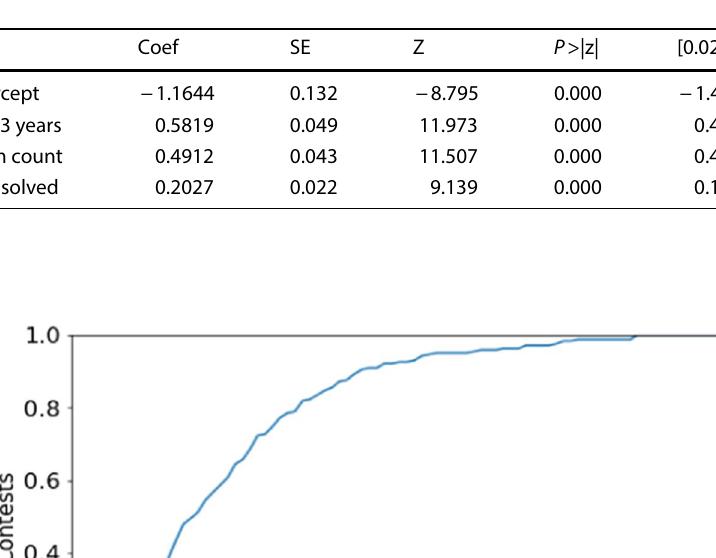
Table 5 Logistic regression model coefficients